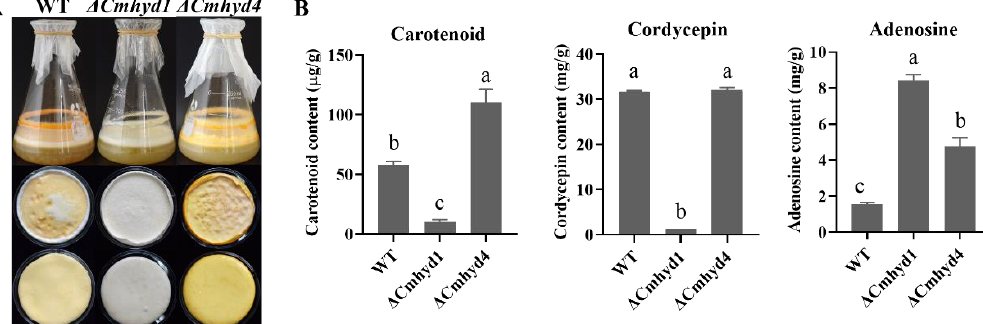
Figure 4. The morphology and secondary metabolite production of WT, ∆ Cmhyd1 and ∆ Cmhyd4 strains by two-stage cultivation. ( A ) Fermentation broth, upper and reverse sides of the vela from the WT, ∆ Cmhyd1 and ∆ Cmhyd4 strains after two-stage cultivation for 18 d; ( B ) Contents of carotenoid in the vela, cordycepin, and adenosine in fermentation broth for the WT, ∆ Cmhyd1 , and ∆ Cmhyd4 strains. Error bars represent the SD of three biological replicates with three technical replicates. Different letters above the bars represent significant differences ( p < 0.05).